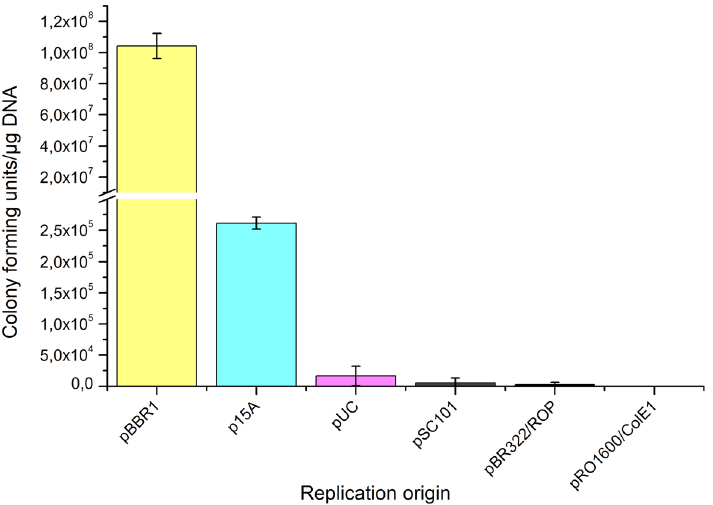
Figure 3. Analysis of variable Ori in K. intermedius ENS15. The replication origins pBBR1, p15A, pUC, pSC101, pBR322/ROP and pRO1600/ColE1 are present in pSEVA331, pSEVA361, pSEVA381, pSEVA371, pSEVA391 and pSEVA341, respectively. The presented data includes the mean values and standard deviations from duplicate cultivations in HS-glucose agar containing 340 µg/ml